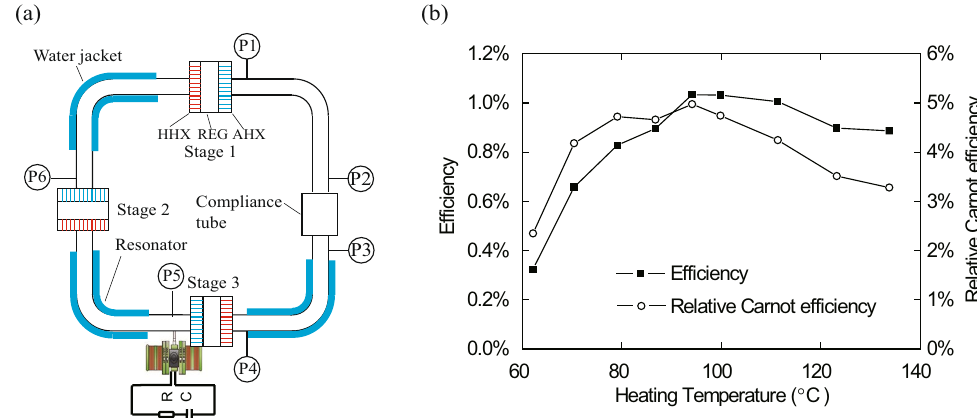
Figure 5. Schematic of the electric generator driven by a three-stage LTAPM and its efficiency and relative Carnot efficiency versus heating